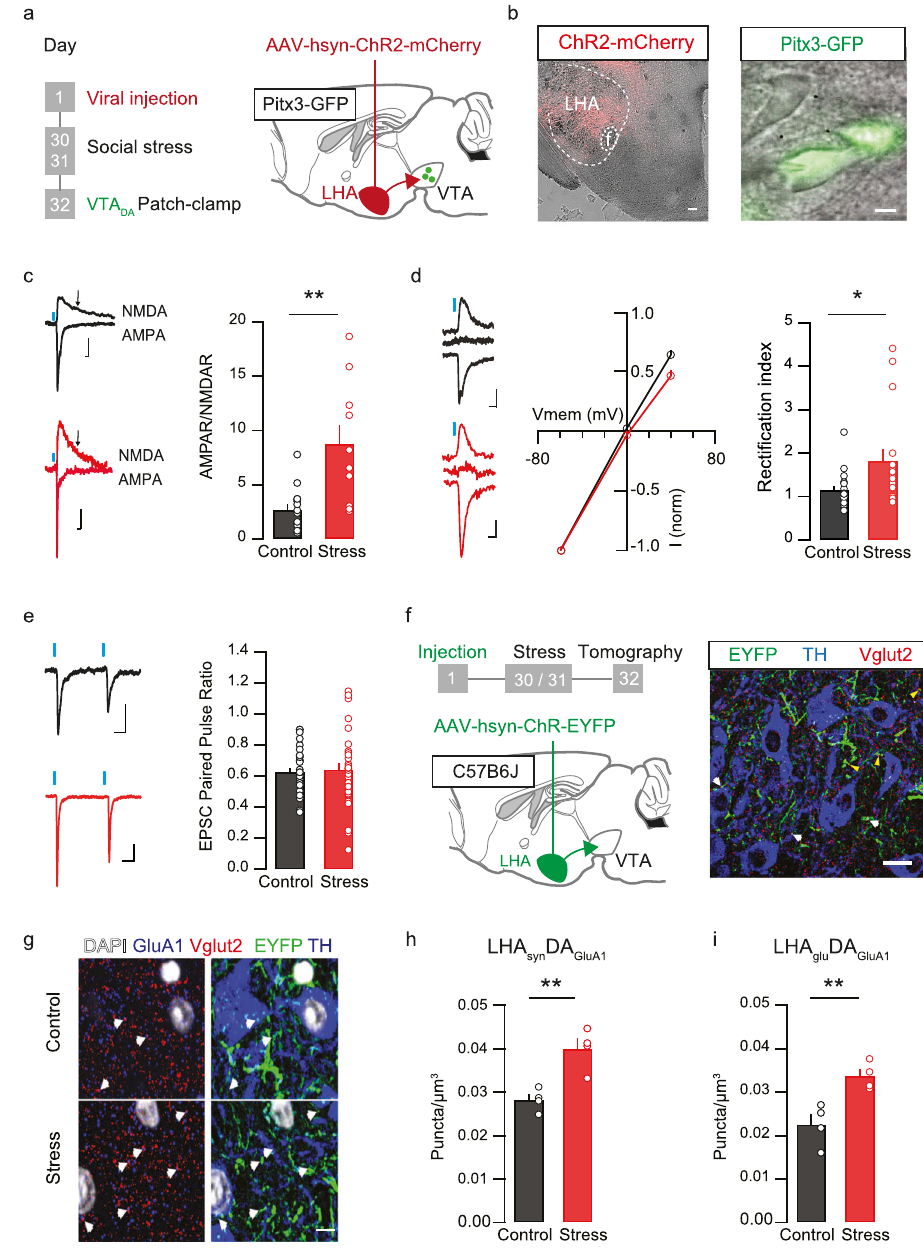
Fig. 3 | Social stress potentiates LHA glu -VTA DA synapses via AMPA receptor Right: Representative image of VTA slice stained for LHA fi bers (YFP: green), DA modi fi cations. a Timeline and schematic for electrophysiological patch clamp neurons (TH: blue) and glutamatergic fi bers (Vglut2: red). White arrows: puncta overlap between YFP, Vglut2 and TH. Yellow arrows: puncta with overlap between experiments. b Representative image of an LHA slice with ChR2-mCherry in red. YFP and Vglut2. Scale bar: 10 µ m. g Representative images of reconstructed VTA Scale bar: 100 µ m. Anatomical reference point: f fornix. Right: Image of green fl uorescent VTA slices with array tomography. On the left side the white arrows indicate overlap DA neurons (Pitx3-GFP) with patch clamp electrode. Scale bar: between Vglut2+ glutamatergic terminals (red) with GluA1 subunits (blue). On the 10 µ m. c AMPAR-NMDARratiosatLHA glu -VTA DA synapsesincreasepoststress.Left: representative I-AMPAR and I-NMDAR traces, Blue rectangle: start of LED stimula- rightsidethesamesliceisshown,wherethewhitearrowsindicateoverlapbetween tion.Scalebar:20ms,20pA.I-AMPARmeasuredat − 65mV,I-NMDARat+40mVat LHA terminals (YFP) and dopamine neurons (TH:blue). In both cases DAPI-stained 100ms from stimulation onset (black arrows). Right quanti fi cation of AMPAR/ nuclei are shown (white). The top row shows an example for a control mouse, and NMDARs +SEMs ( n cells control=15, n cells stress=10, One-Way ANOVA, thebottomrowforastressedmouse.Scalebar:5 µ m. h Quanti fi cationofoverlapof F (1,23) =14.72, p =0.001). d AMPAR Recti fi cation index increases at LHA glu -VTA DA LHA terminals, synapsin, GluA1 AMPAR subunits and dopamine neurons, for Con- synapsesafterstress.Left:exampletraces,scalebars:20ms,10pA.Middle:AMPAR trol and Stress conditions (averages+SEMs, mice per group n =4, One-Way current at − 60mV, 0mV and +40mV normalized to AMPAR current at − 60mV ANOVA,F (1,6) =18.26, p =0.005). i AshbutfortheoverlapofLHAterminals,Vglut2, GluA1-AMPAR subunits and dopamine neurons for Control and Stress conditions ( n cellscontrol=18, n cellsstress=17).Right:Averages+SEMs( n cellscontrol=18, p =0.02). e Paired pulse ratio of n cells stress=17, One-Way ANOVA, F (averages+SEMs, mice per group n =4, One-Way ANOVA, F (1,6) =14.9, p =0.008). (1,33) =5.81, LHA glu -VTA DA neurons does not differ due to stress. Left: example traces. Scale All statistical tests were performed two-sided * p <0.05, ** p <0.01. Source data are provided as a Source Data fi le. bars:25pA,25ms.Right:Averages+SEMs( n cells=31pergroup,One-WayANOVA, F (1,60) =0.02, p =0.89). f Left: Schematic for Array Tomography experiment.